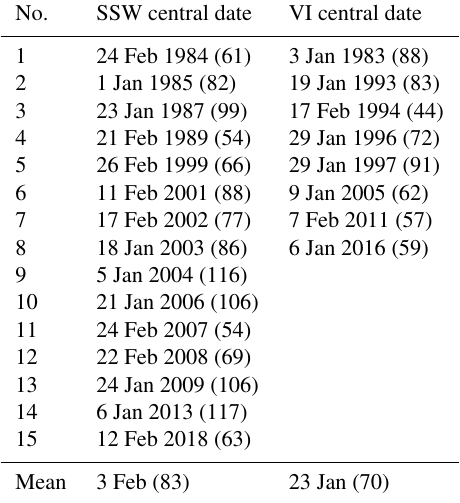
Table 1. Central dates t 0 of SSWs and VIs. Numbers in parentheses indicate length of time (in days) between the central date and the following FW, i.e., t FW − t 0